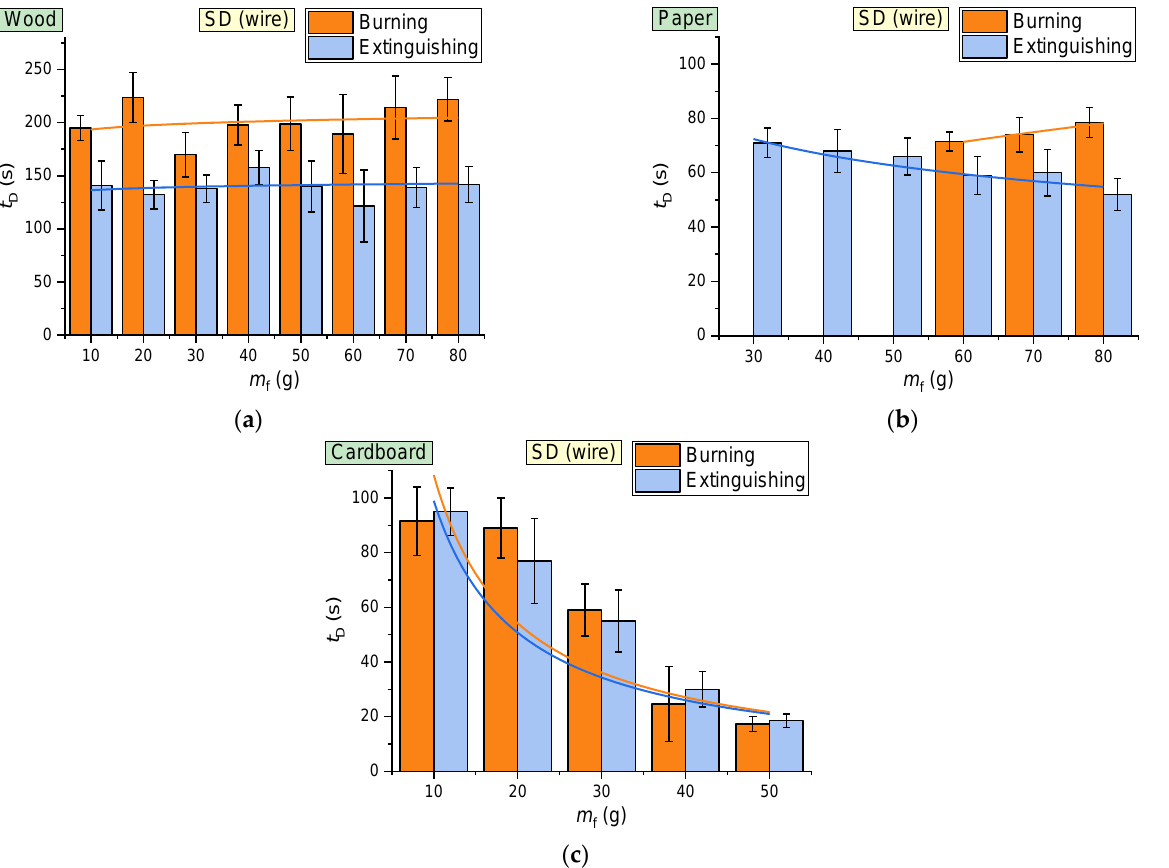
Figure 6. Activation delay times of SD (in the circuit), when varying the sample mass in the experiments with open flame: ( a ) wood; ( b ) paper; ( c ) cardboard.